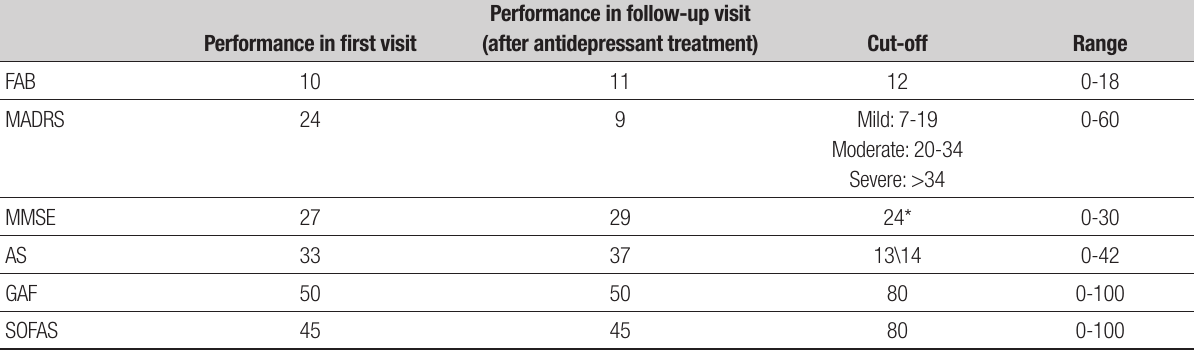
Table 1. Patient performance before and after antidepressant treatment.